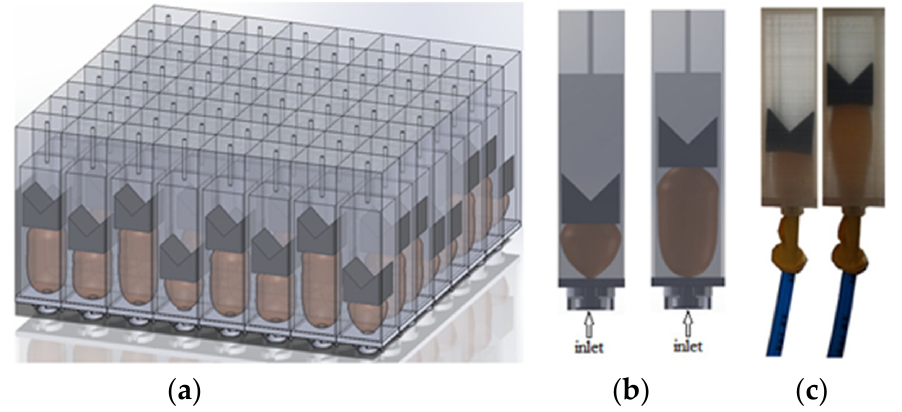
Figure 10. Tuneable Helmholtz resonator showing ( a ) a rendering of an experimental metamaterial design, composed of tuneable Helmholtz resonators that are actuated by inflatable balloons, ( b ) the variations of the plunger clearance depicted with the balloon inflated and deflated and ( c ) clearances as shown in the experimental prototype [92].